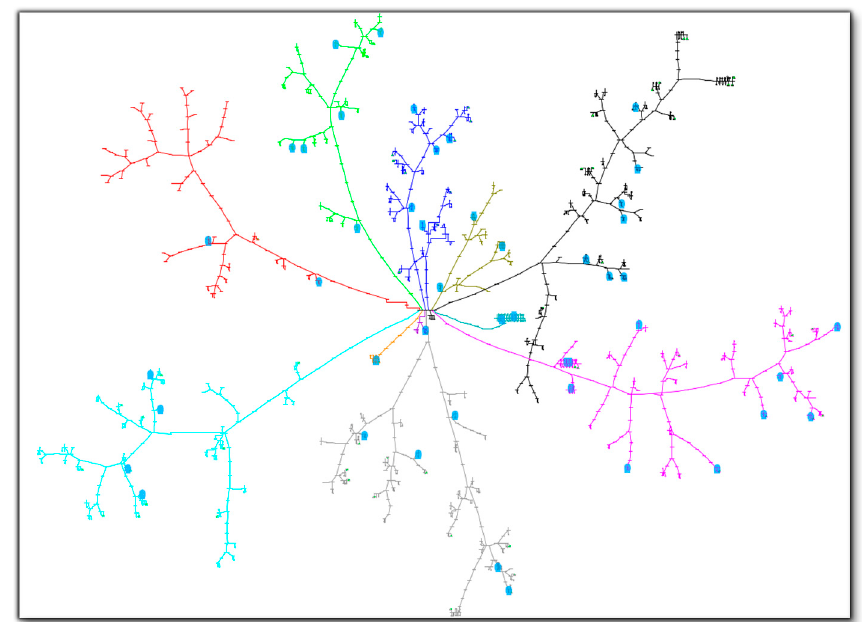
Figure A13. Use case 10—Location of PVs.